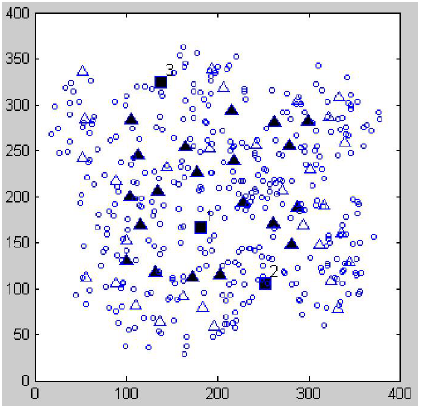
Fig. 3. Location of facilities and customers Fig. 4. Location, allocation, and routing decisions